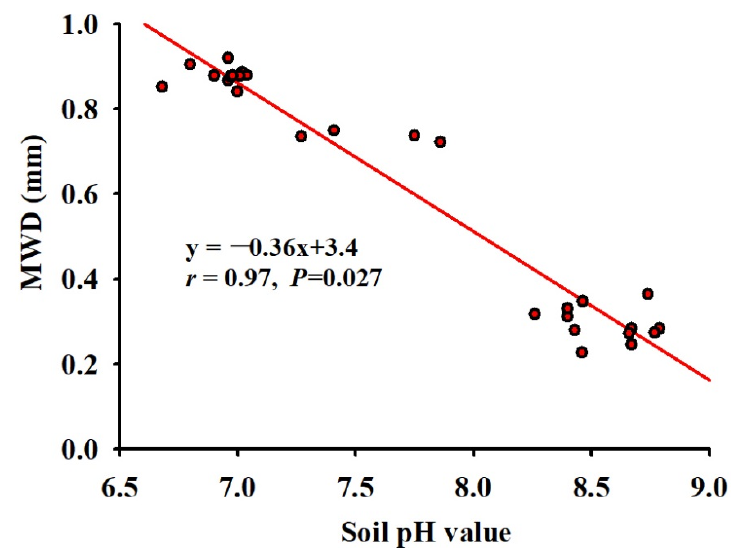
Figure 3. Effects of exogenous EE-GRSP and DE-GRSP on the soil pH value in the rhizosphere of trifoliate orange seedlings. Data (means ± SD, n = 4) followed by different letters above the bars indicate significant differences ( p < 0.05) between treatments.